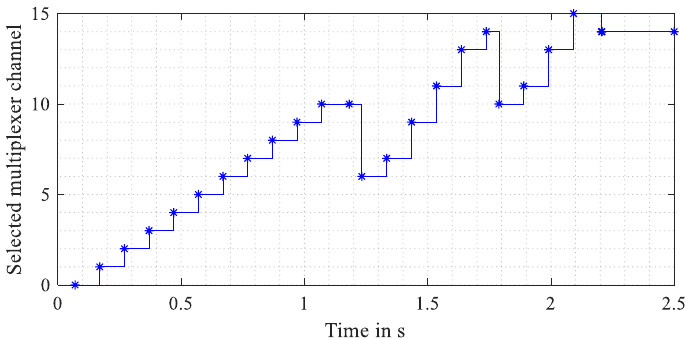
Figure 24. Multiplexer channels during the scanning phase and dual check-neighbors phase of C14.